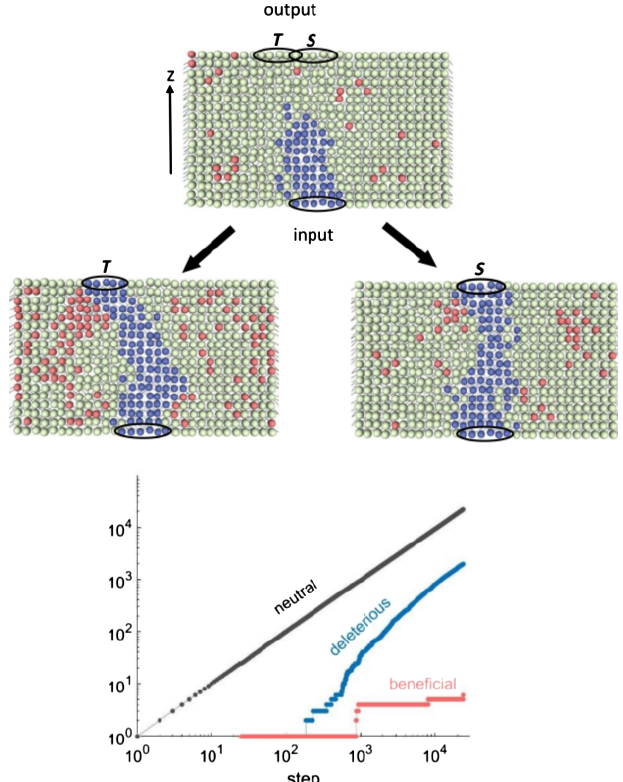
FIG. 3. Dimensional reduction of the genotype-to-phenotype map. Dimension measurement for the straight ( S , top) and tilted ( T , bottom) cases. 10 6 independent functional configurations are foundfortheinput-outputproblem.Anestimateforthedimensionof the solutions is the correlation length, the slope of the cumulative fraction of solution pairs as a function of distance. In configuration space (red),the distanceis the numberofAAs (outof540)witha dif- ferent rigidity state. The estimated dimension from 10 12 = 2 distances is about 9 (black line) for problem S and 8.5 in problem T . The sequence space is a 2550-dimensional hypercube with 32 510 seque- nces. Most distances are close to the typical distance between two randomsequences ( 2550 = 2 ¼ 1275 ), indicating a high-dimensional solutionspace.Anestimateforthedimensionis ∼ 150 (blackline)for both S and T problems. The similarity of the dimensions in both cases suggests that these numbers are not specific to the